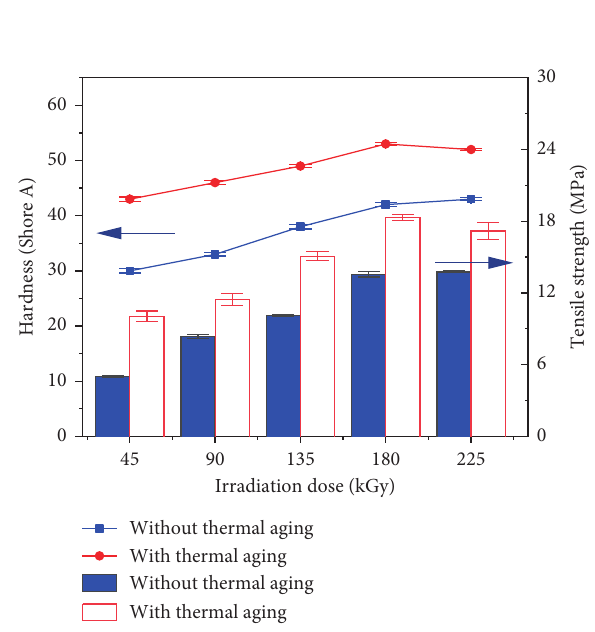
Figure 2: Tensile strength of BR/NR blends with different radiation